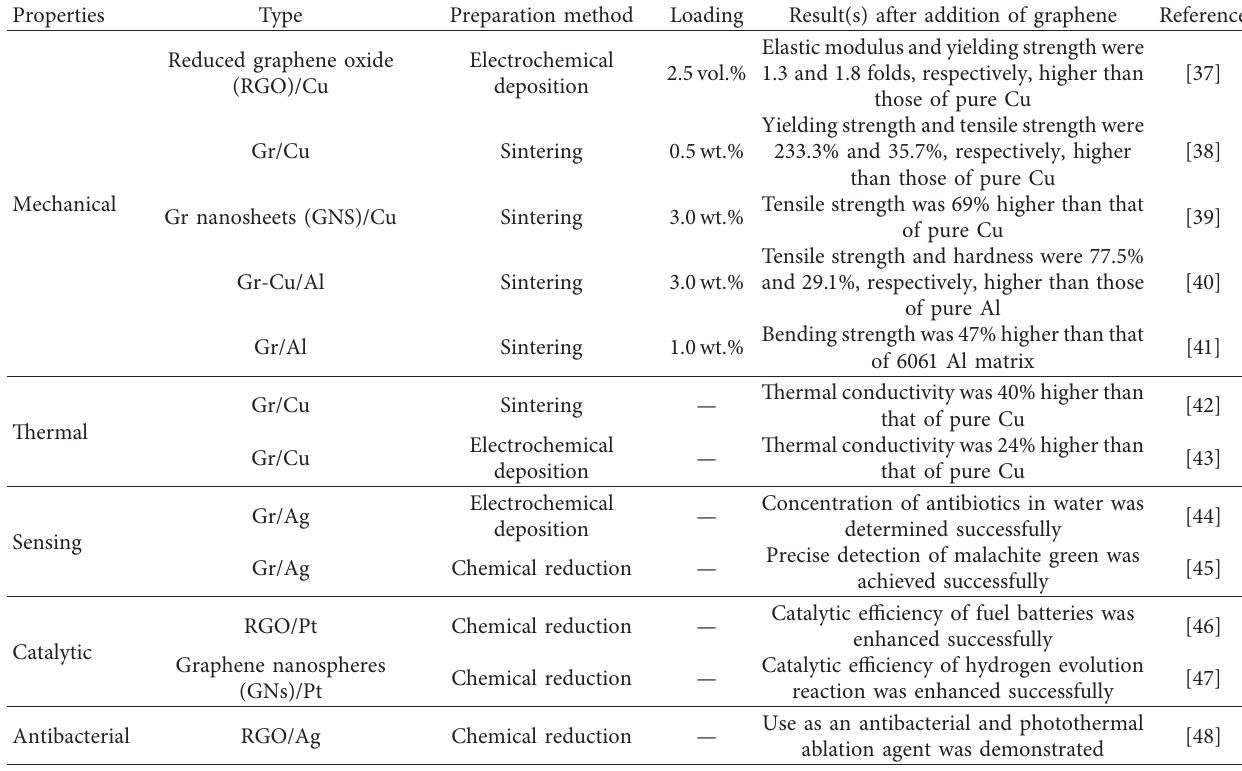
Table 2: Properties and preparation methods of graphene/metal composite